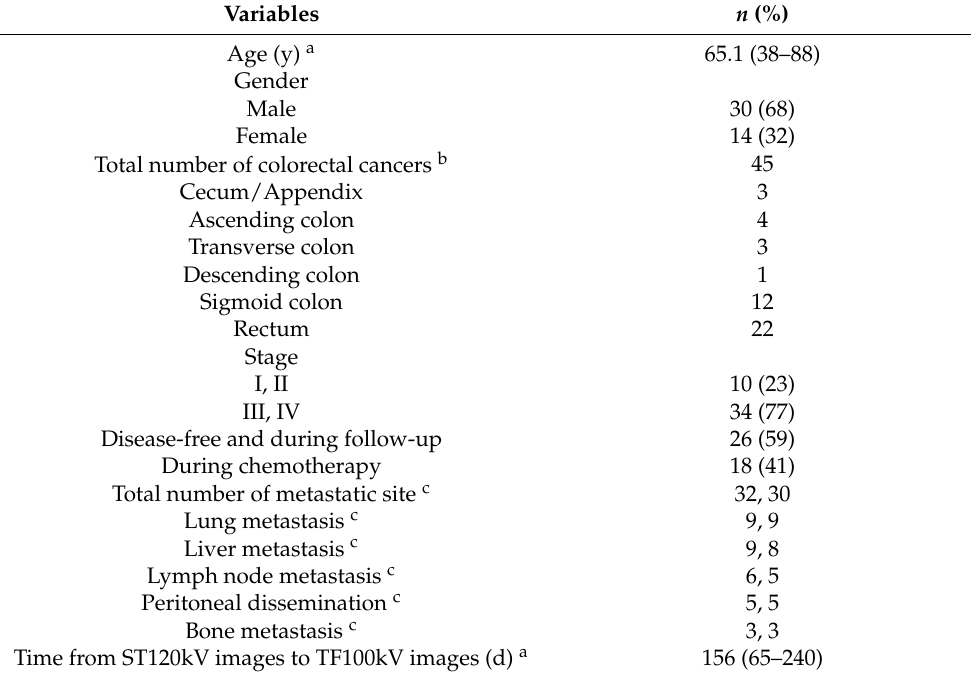
Table 2. Patient and clinicopathological characteristics of the 44 eligible